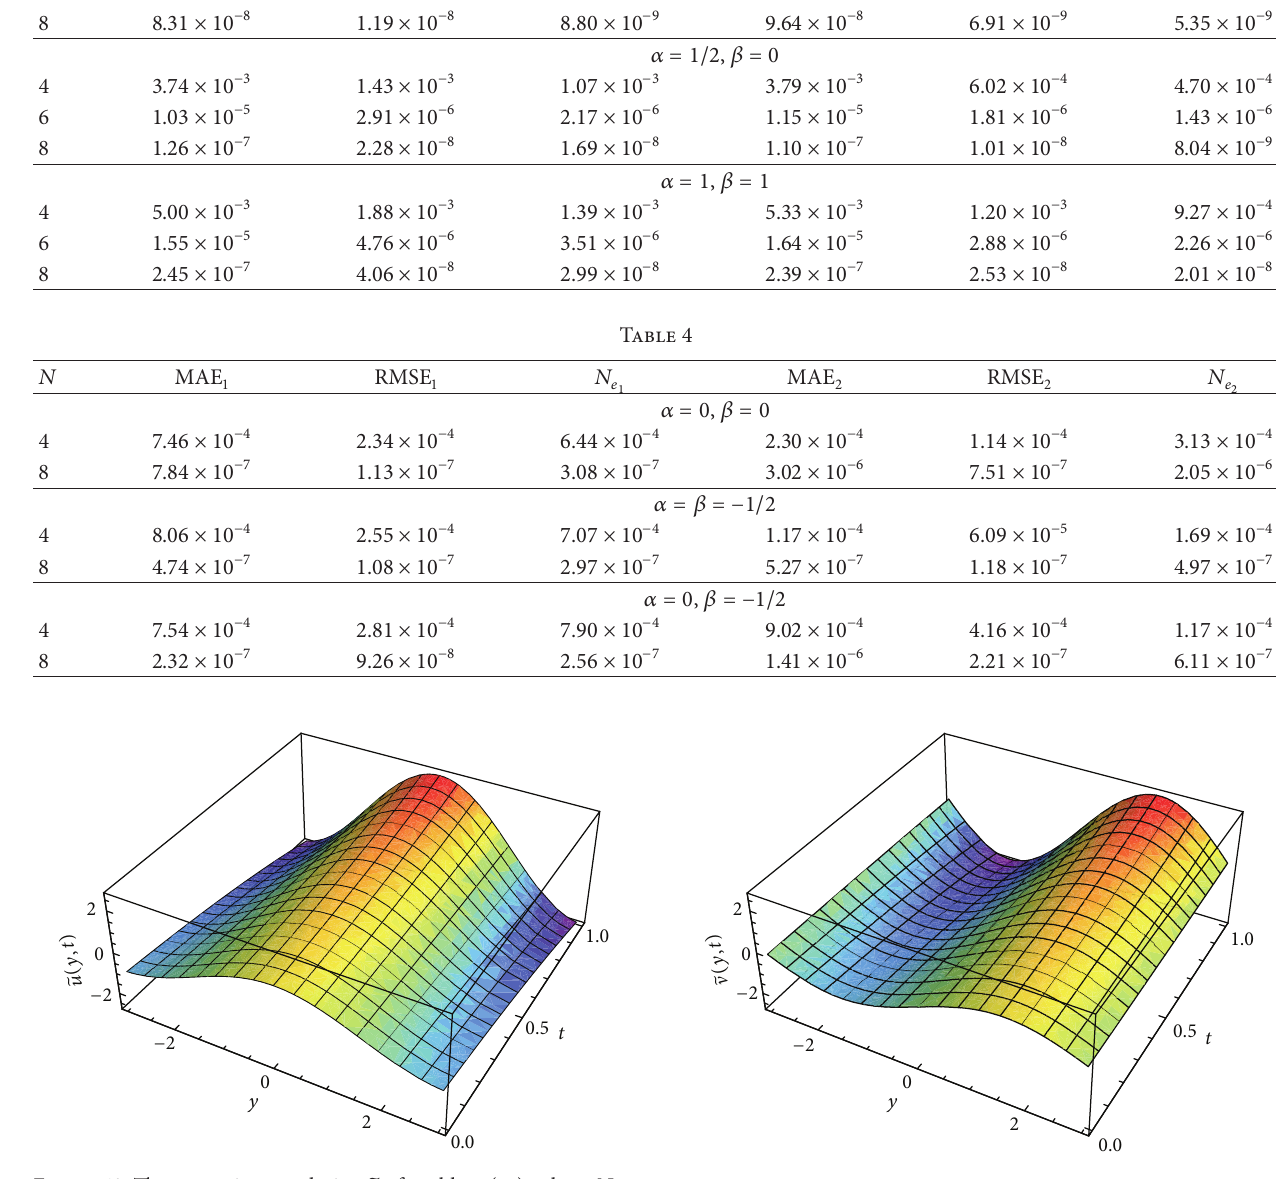
Figure 14: The approximate solution ̃ V of problem (55), where 𝑁 = 10 and 𝛼 = 𝛽 = 1/2 in the interval [0,1]